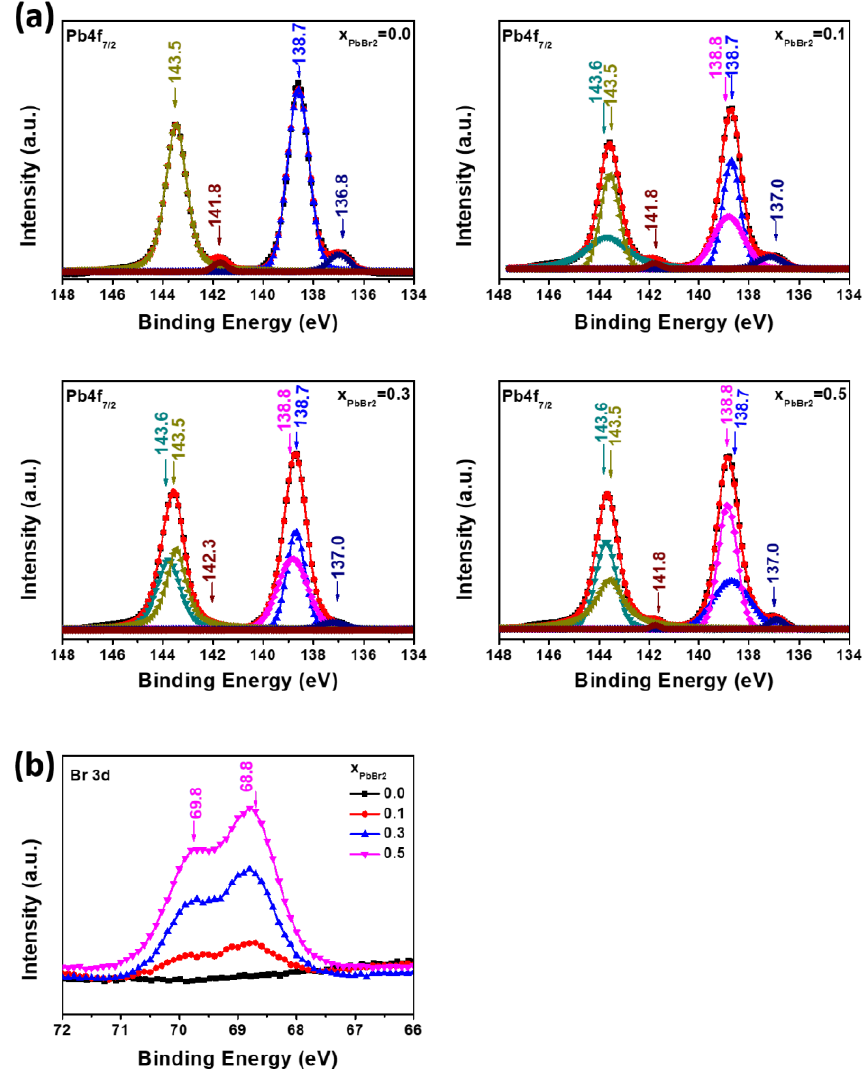
Figure 4. ( a ) XPS of Pb 4f spectra were de-convoluted into three peaks at 138.7, 138.6, and 137.0 eV, which are assigned to Pb 4f 7/2 core-levels of PbI 2 , PbBr 2 , and Pb atom in the lead halide films fabricated at x = 0, 0.1, 0.3, and 0.5; ( b ) XPS Br 3d core-level spectra of lead halide films fabricated at x = 0.0, 0.1, 0.3, and 0.5.